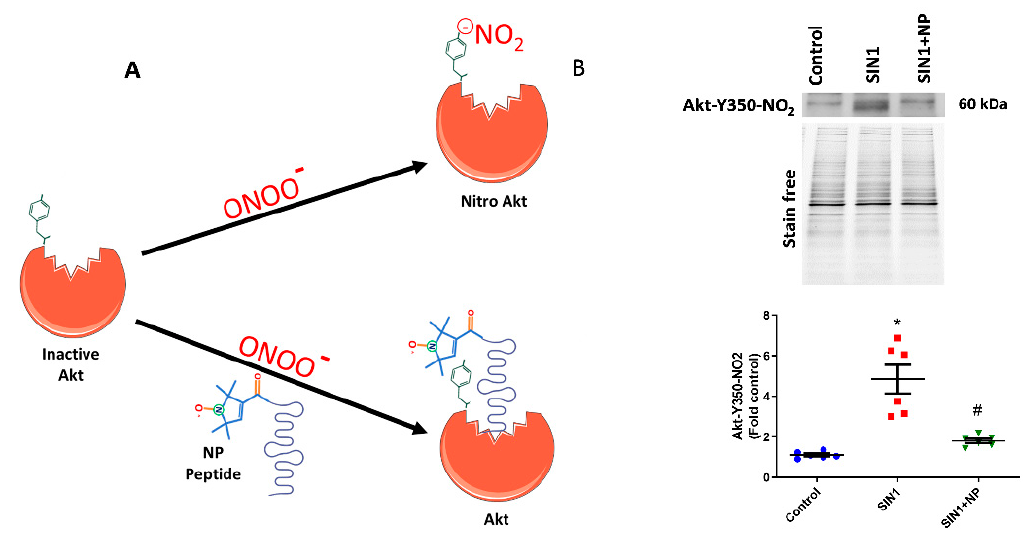
Figure 1. Nitroxide-conjugated peptide blocked nitration of Akt. ( A ) Schematic diagram of nitroxide antioxidant conjugated peptide binding at tyrosine 350 residue of Akt and inhibition of peroxynitrite radical induced Akt nitration. ( B ) SIN-1 (1 mM) for 1 h significantly increased Y350 nitration of Akt in human pulmonary artery endothelial cells (HPAECs), and pretreatment with nitroxide peptide (NP) showed a 55% reduction in Akt nitration. Also, this demonstrates the specificity of our antibody towards Y350-nitroAkt. Data expressed as mean ± SE normalized on total protein (stain free); N = 6; * p < 0.05 versus control; # p < 0.05 versus SIN-1 by ANOVA.